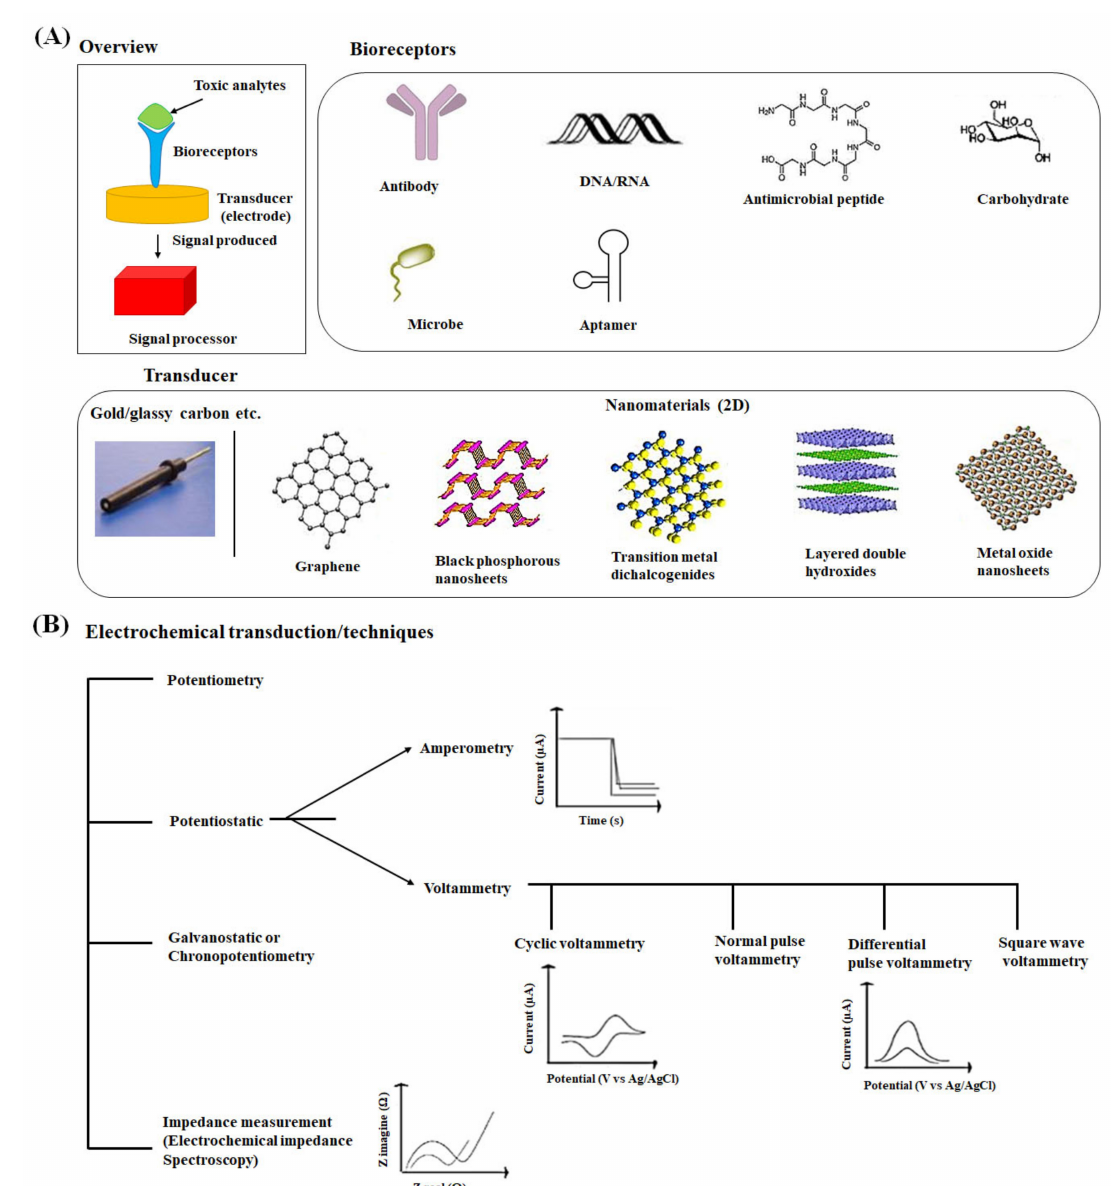
Figure 2. ( A ) Schematic illustration of a typical electrochemical food sensor and its various components, including bioreceptors, transducer, and signal processor [68]. The structure of two-dimensional nanomaterials used to fabricate the electrode surfaces in biosensors has been shown [69]. ( B ) Different types of electrochemical techniques have been presented